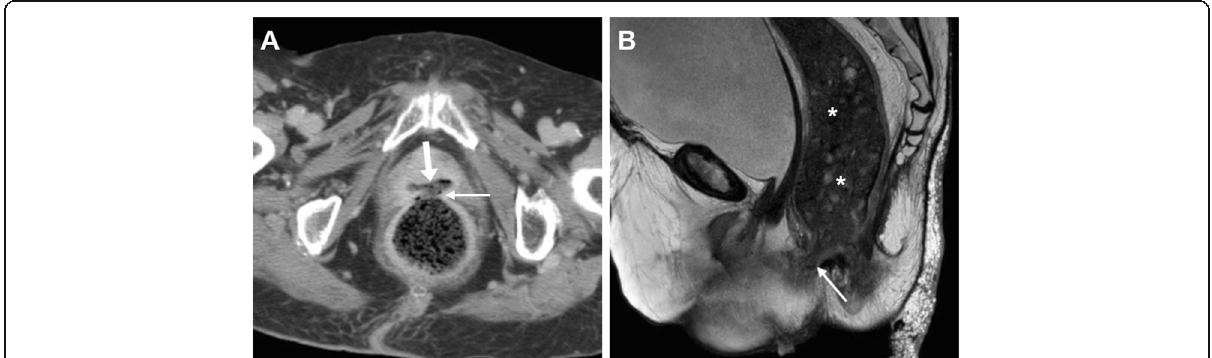
Fig. 5 Two different radiation-induced recto-VF in elderly women with history of pelvic radiotherapy. a Axial CT image shows midline fistula (thin arrow) filled by faeces connecting the anterior aspect of the rectum to the vagina (arrow). b Sagittal T2-weighted MRI image shows a 1-cm wide fistula (thin arrows) between the most distal aspect of stool-filled rectum (*) and vagina